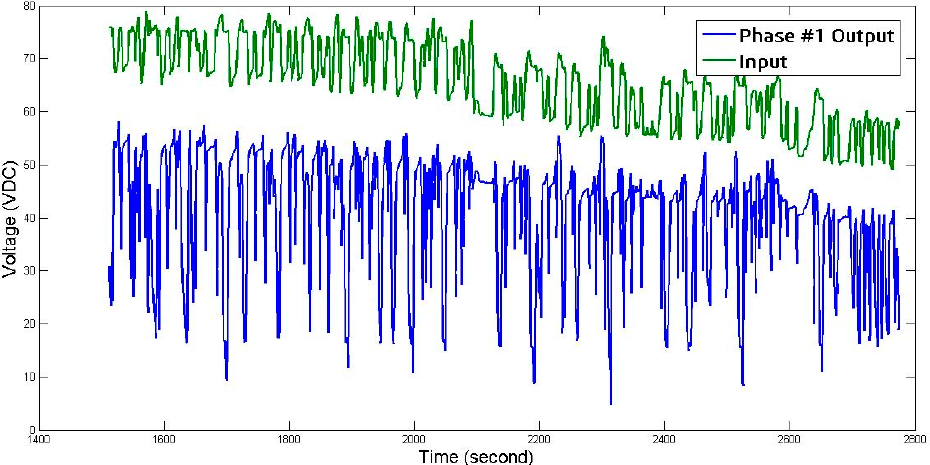
Figure 9. Input voltage vs. output voltage—phase #1.